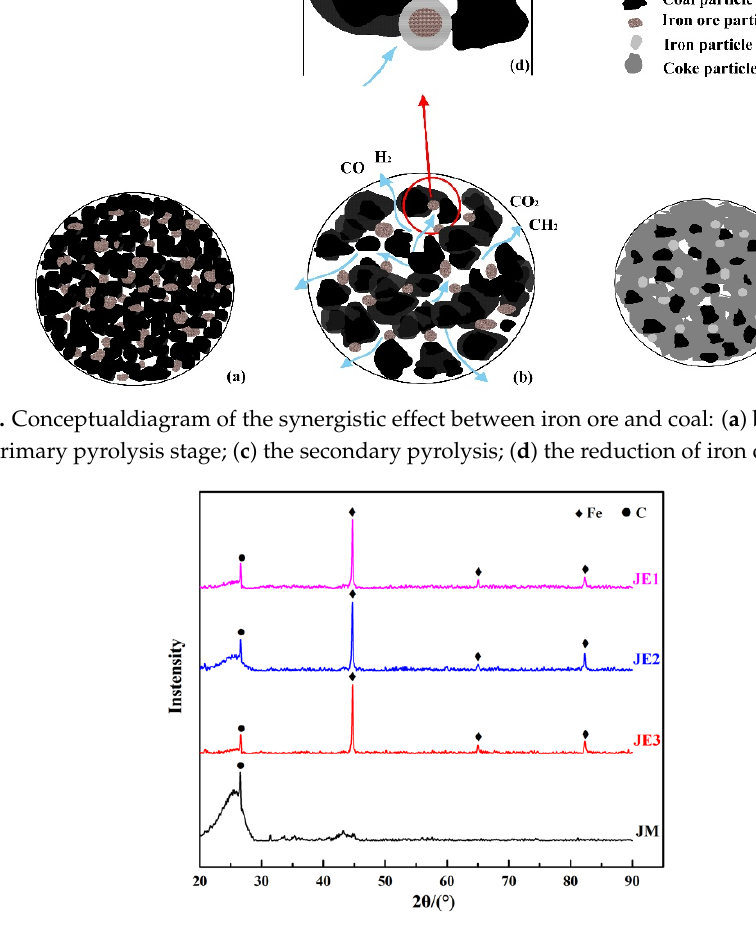
Figure 10. XRD patterns of the coal-iron ore briquette with different particle size iron ore after coking.